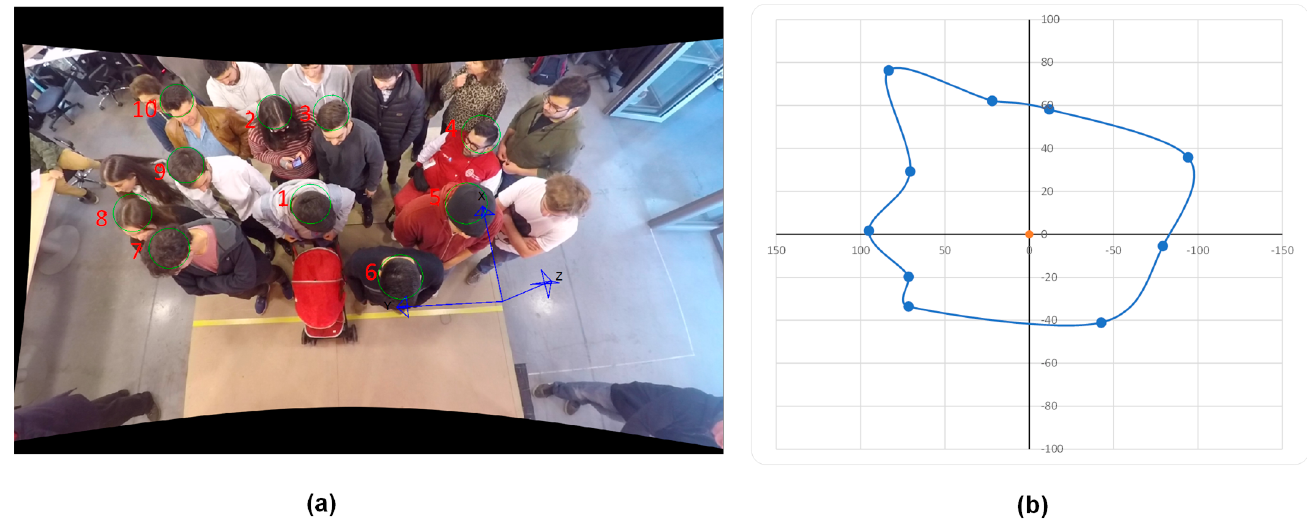
Figure 3. Example of the method used to identify a passenger with reduced mobility (passenger N°1) and those passengers around him/her (passengers N° 2 to N° 10): ( a ) passenger N°1 (pushing a pram) surrounded by 9 passengers (passengers N°2 to N°10); ( b ) dimensions in cm of the area used by the passenger N°1, who is located at (0,0).